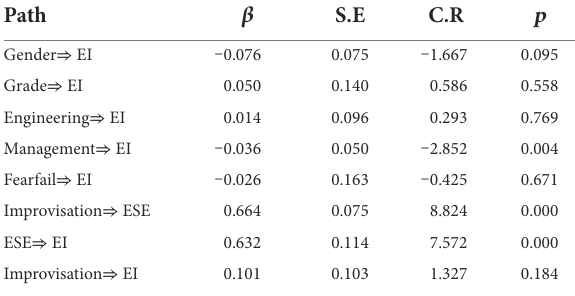
TABLE 4 | Mediation model